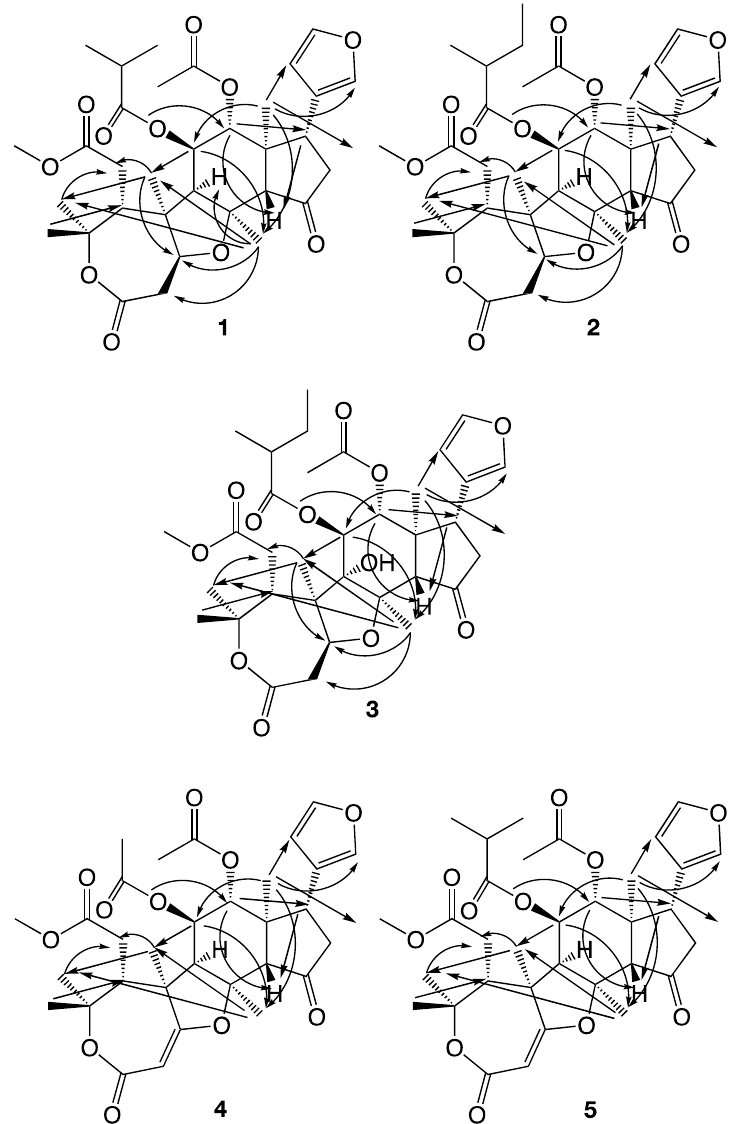
Figure 5. NOESY correlations observed with compounds 1 – 5 .